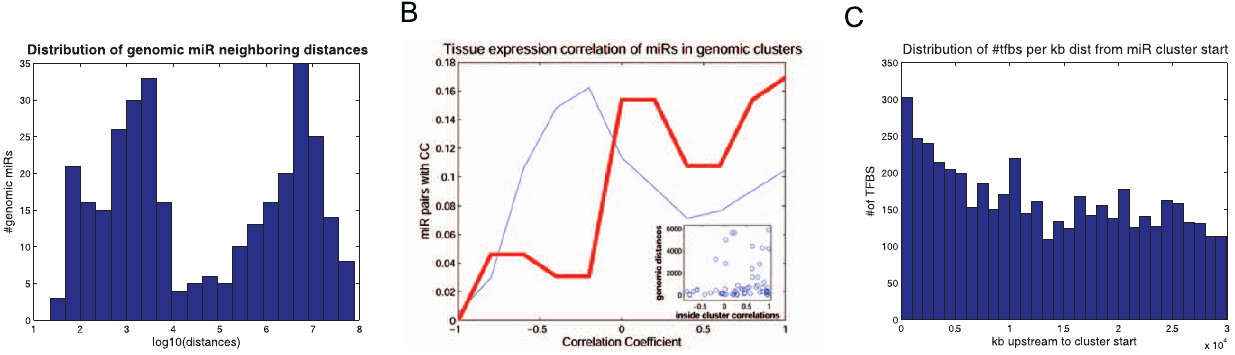
Figure 6. Analysis of miR Clusters in the Human Genome (A) Distribution of distances between all neighboring pre-miR genes in the human genome. (B) Distribution of tissue expression correlations between pairs of miRs: all possible pairs in the data (thin blue line) and pairs of miRs which reside in shared clusters (thick red line). In the inset are shown tissue expression correlations between pairs of miRs in the same genomic clusters versus distances between them. (C)DistributionofnumberofconservedTFBS30kbupstreamofthe5 9 mostnucleotideineachmiRclusters.ConservedTFBSsweretakenfromUCSChg17.